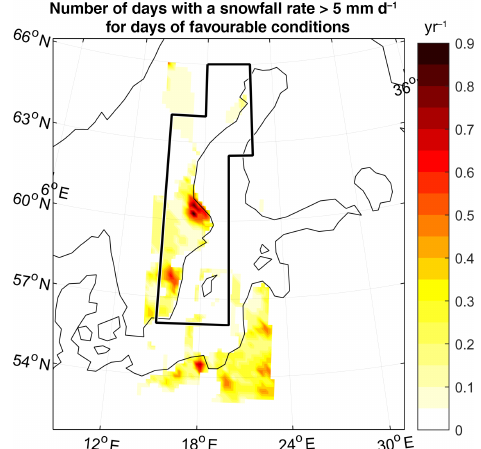
Figure 5. Frequency of occurrence for favourable atmospheric con- ditions with convective snow bands causing a snowfall rate greater than 5mmd − 1